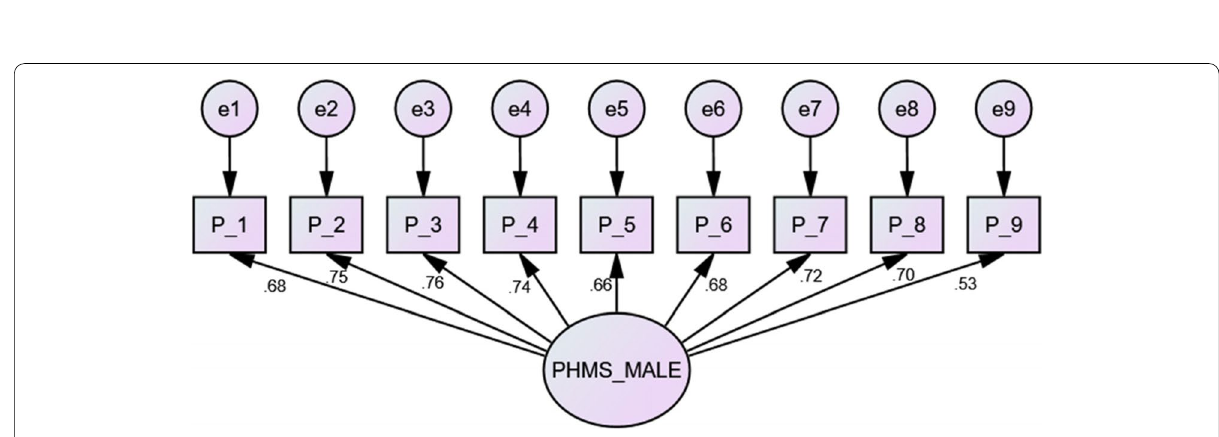
Fig. 3 Confirmatory factor analysis model for male data from the second subsample data including standard loadings and standardized errors. n 266. Final confirmatory factor analysis (CFA) model of the Positive Mental Health (PMH) scale